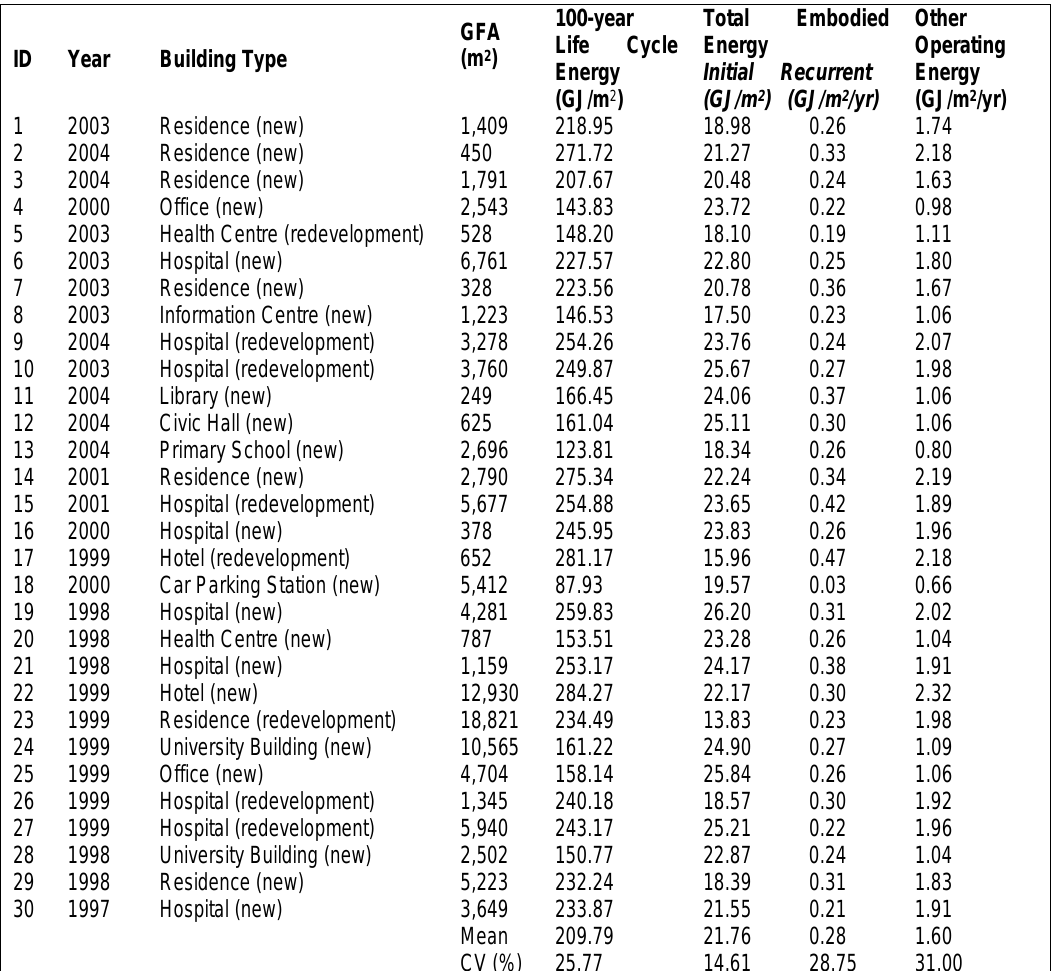
Table 1: Case Study: Base Information & Energy Summary (per m 2 Gross Floor